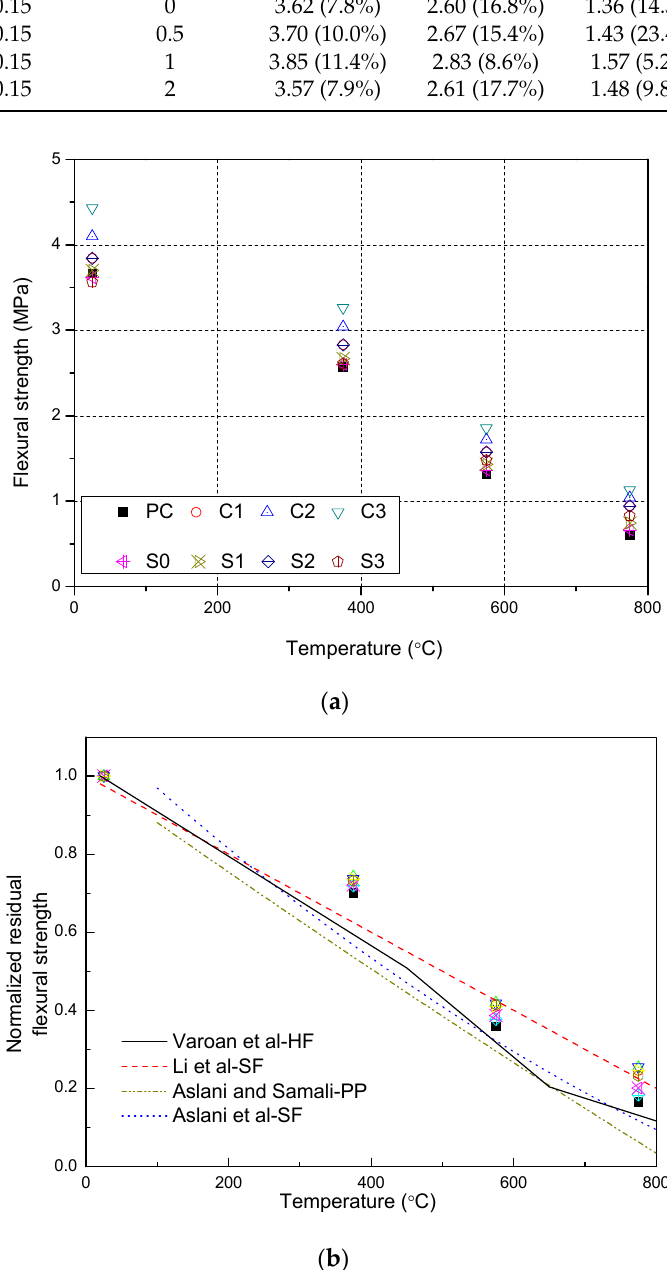
Figure 6. Evolution of the NSCFRC flexural strength at high temperatures: ( a ) The residual flexural strength after exposure to high temperature; ( b ) The normalized residual flexural strength after exposure to high temperature.